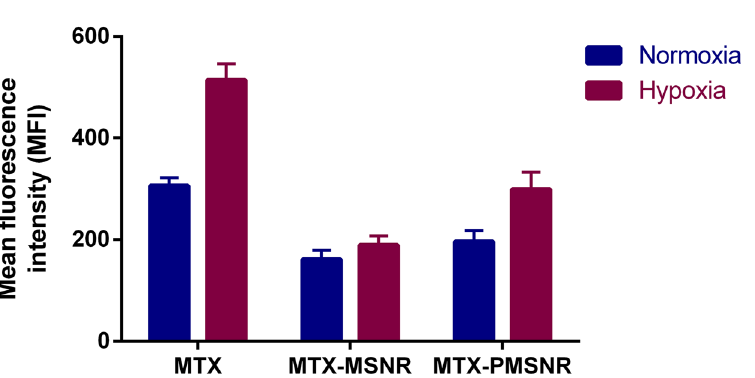
Figure 7. Effect of hypoxia on MDA-MB-231 cell uptake of MTX and MTX-loaded MSNR and PMSNR. Cell uptake shown as mean fluorescence intensity (MFI) of free MTX in the cells measured by flow